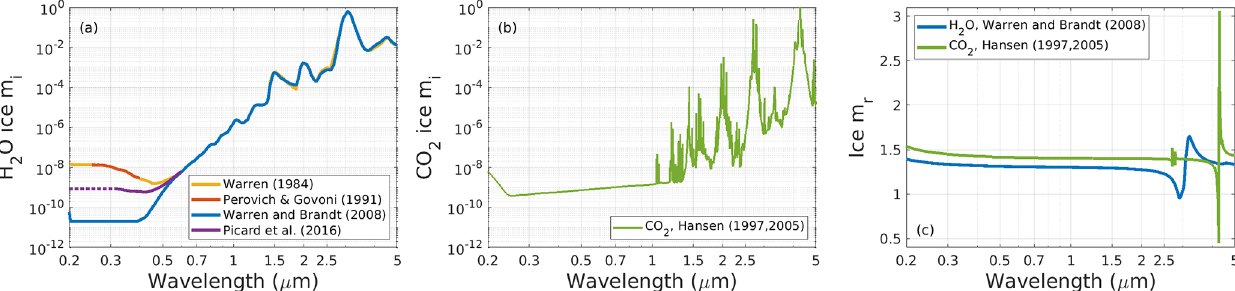
Figure 2. Ice complex refractive index data used in SNICAR-ADv3 including imaginary components ( m i ) of H 2 O ice (a) , imaginary com- ponents ( m i ) of CO 2 ice (b) , and real components ( m r ) of both types of ice (c)